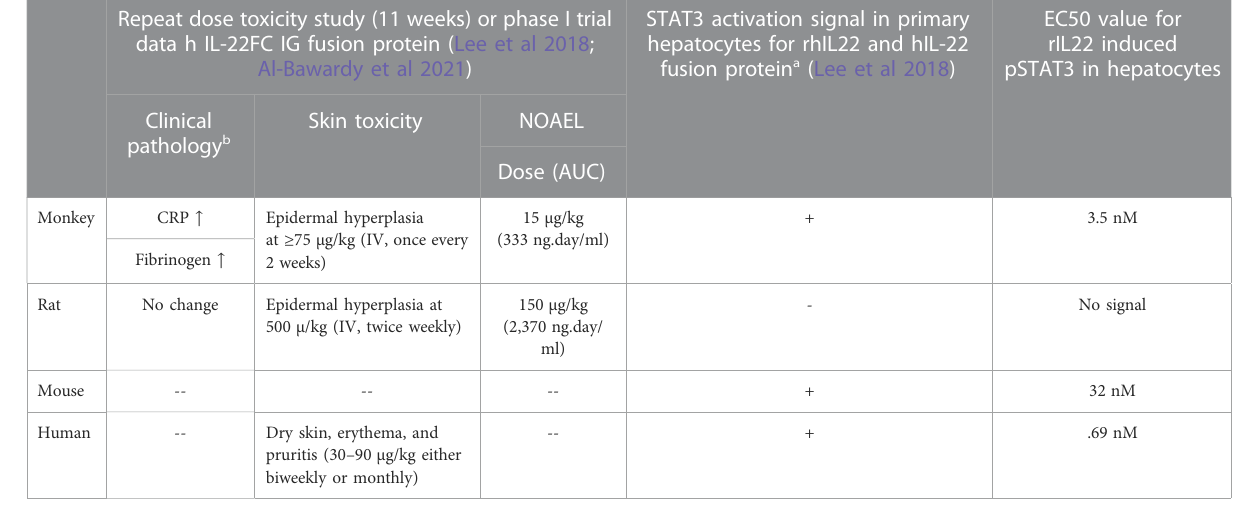
TABLE 4 Summary of species sensitivity difference for IL22 signaling and associated pharmacology and safety fi ndings. Repeat dose toxicity study (11 weeks) or phase I trial data h IL-22FC IG fusion protein (Lee et al